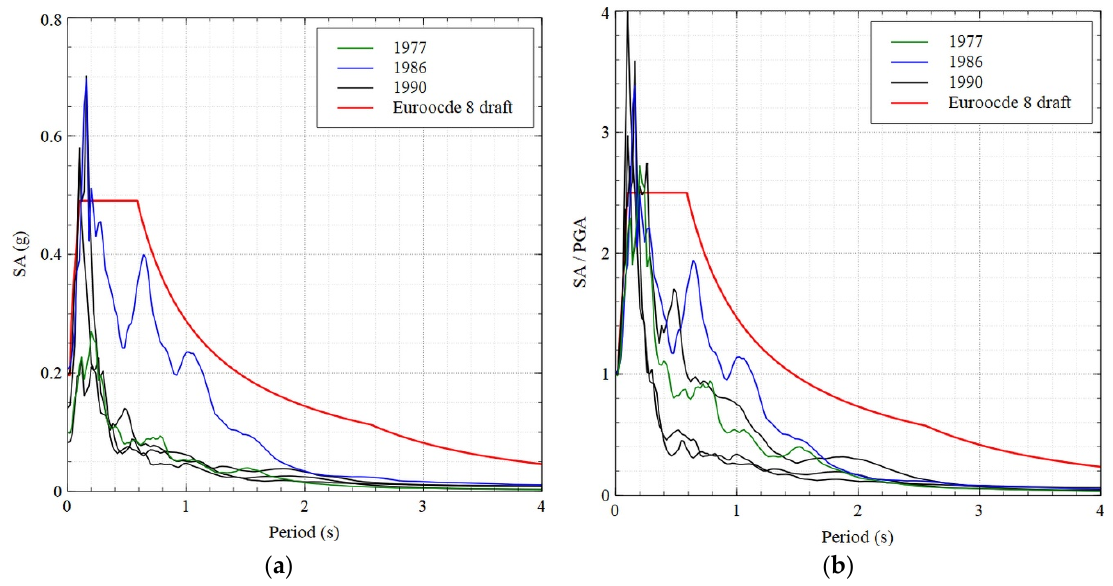
Figure 9. A comparison between the ( a ) design absolute acceleration response spectrum (with a mean return period of 475 years) for Chisinau, computed using the site amplifications from the Eurocode 8 draft revision [1] and the ground motions recorded during the Vrancea intermediate-depth earthquakes of 1977, 1986 and 1990, and the ( b ) design normalised acceleration response spectrum (with a mean return period of 475 years) for Chisinau, computed using the site amplifications from the Eurocode 8 draft revision [1] and the ground motions recorded during the Vrancea intermediate-depth earthquakes of 1977, 1986 and 1990.